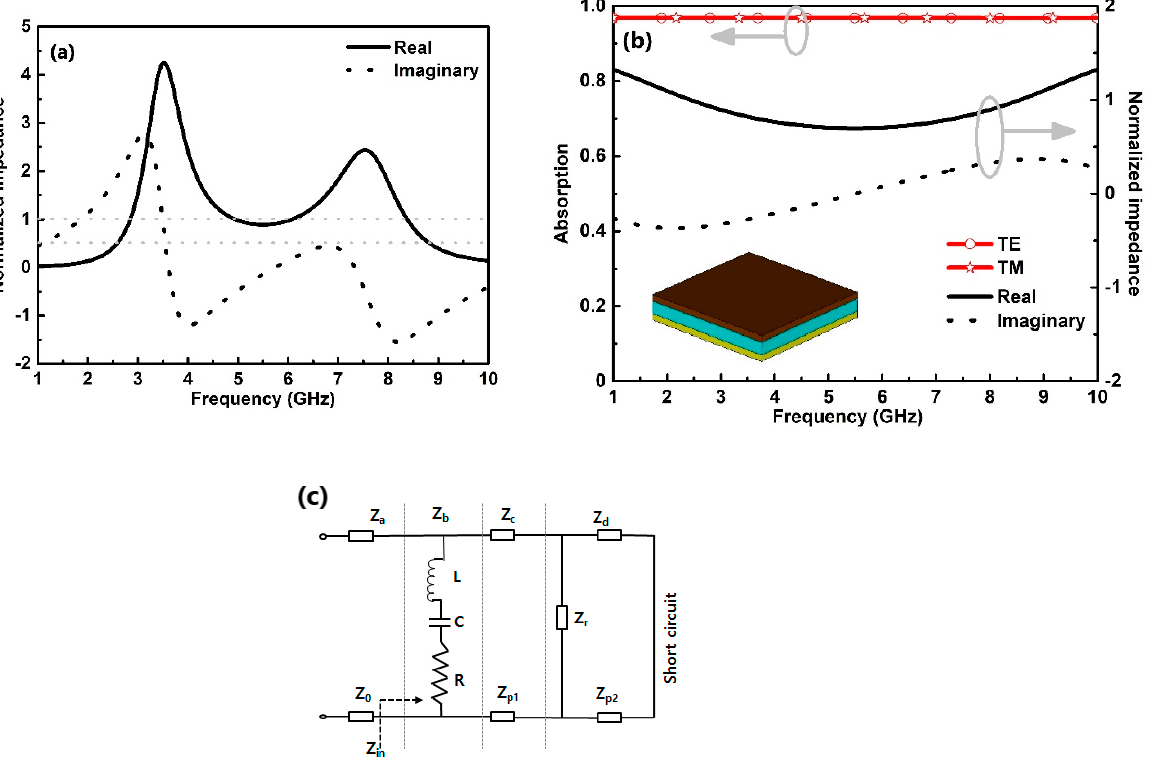
Figure 3. ( a ) Normalized real and imaginary part of the impedance of MA. ( b ) Absorption of the TE and TM polarization, and normalized real and imaginary parts of the impedance of MA without meta-pattern and polyimide-1 layers. ( c ) Equivalent circuit model of the MA.